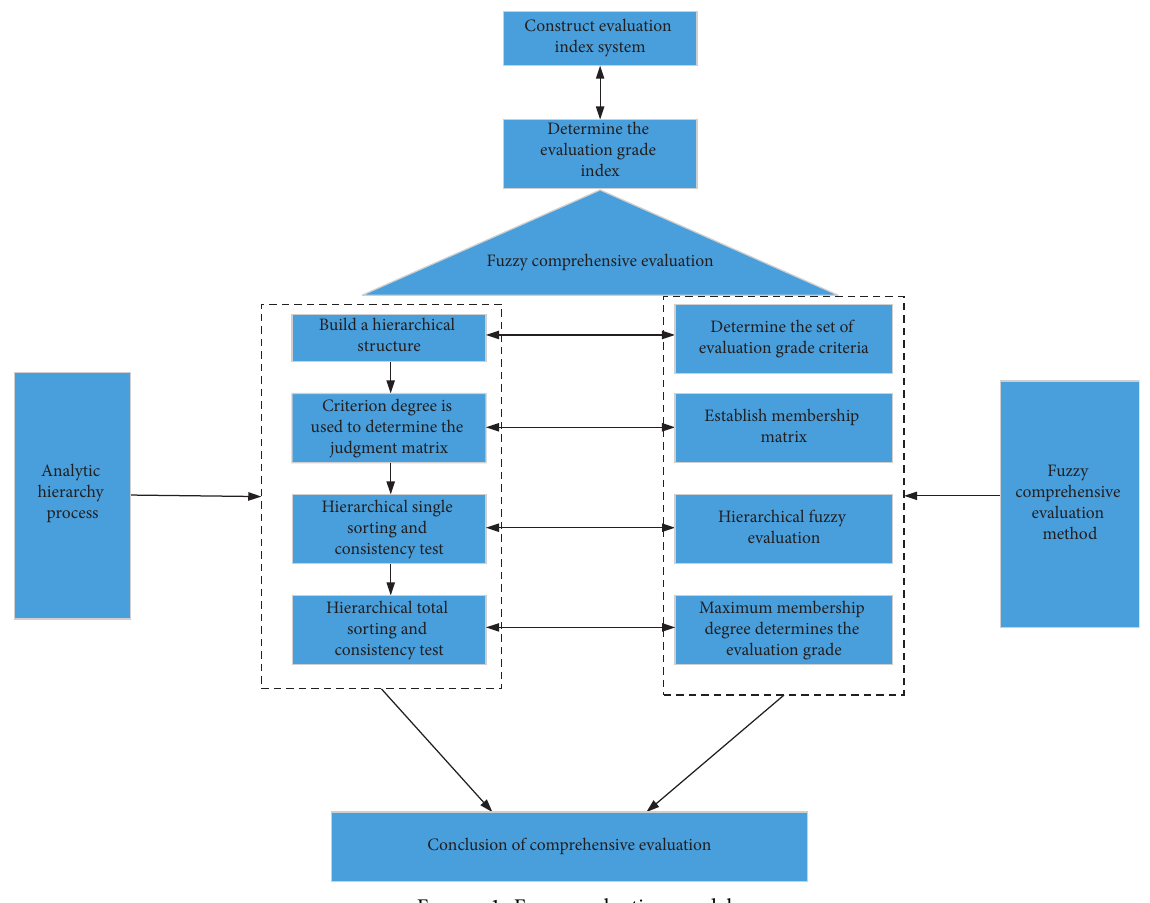
Figure 1: Fuzzy evaluation